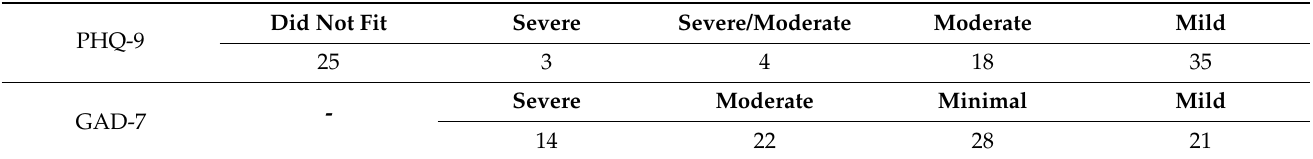
Table 1. Psychological data